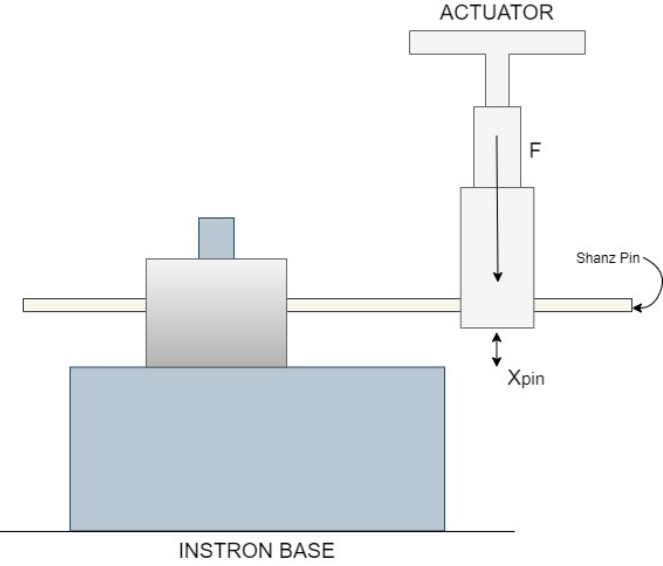
Figure 6. Diagram of pin bending test. The schanz pin is fixed on to the instron base using a testing block and the actuator provides a loading perpendicular to the pin